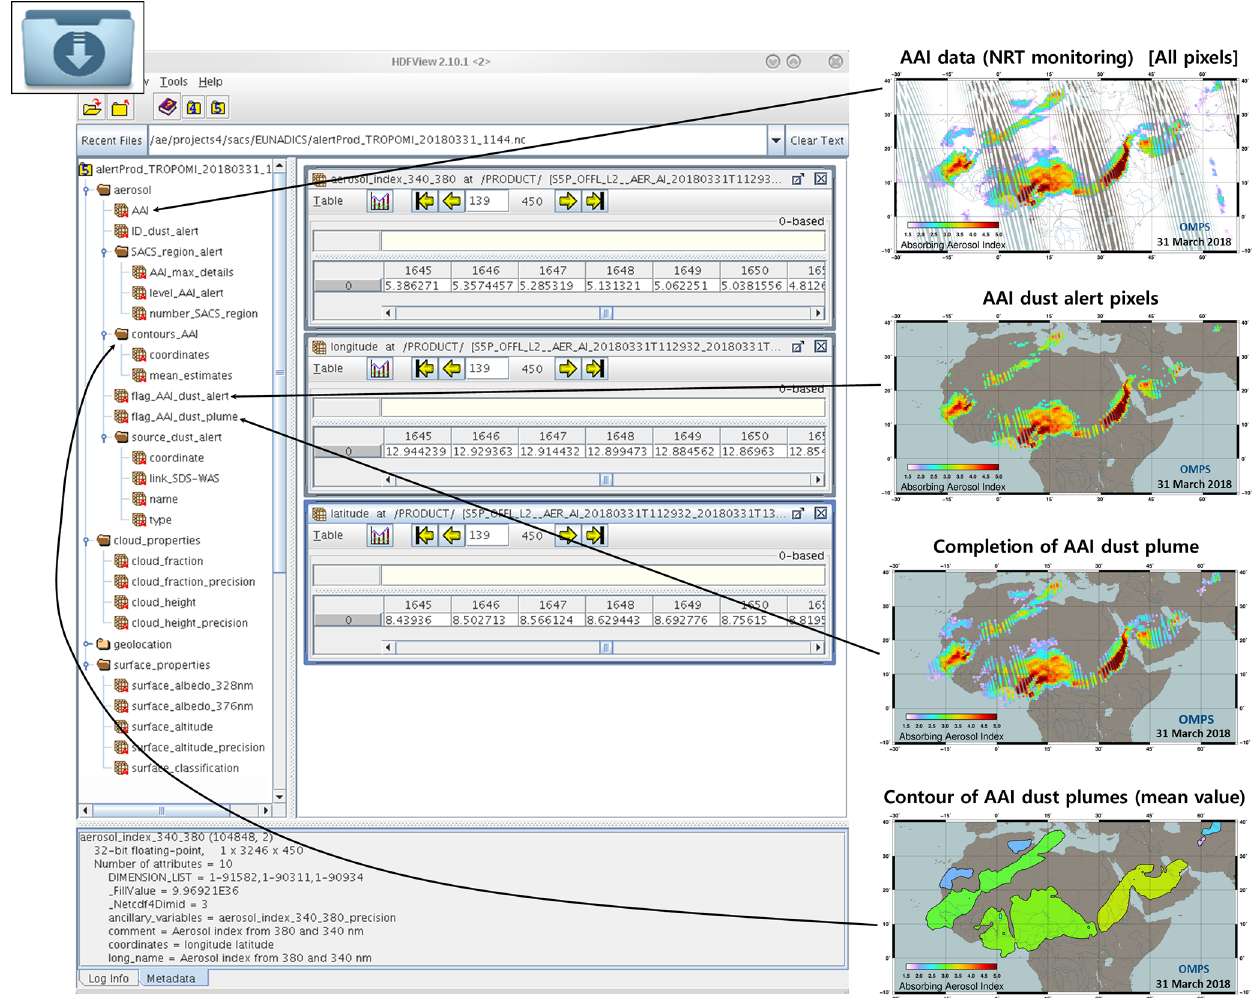
Figure 26. Illustration about the content of a netCDF alert product (NCAP files) related to the Saharan sandstorm detection from OMPS on 31 March